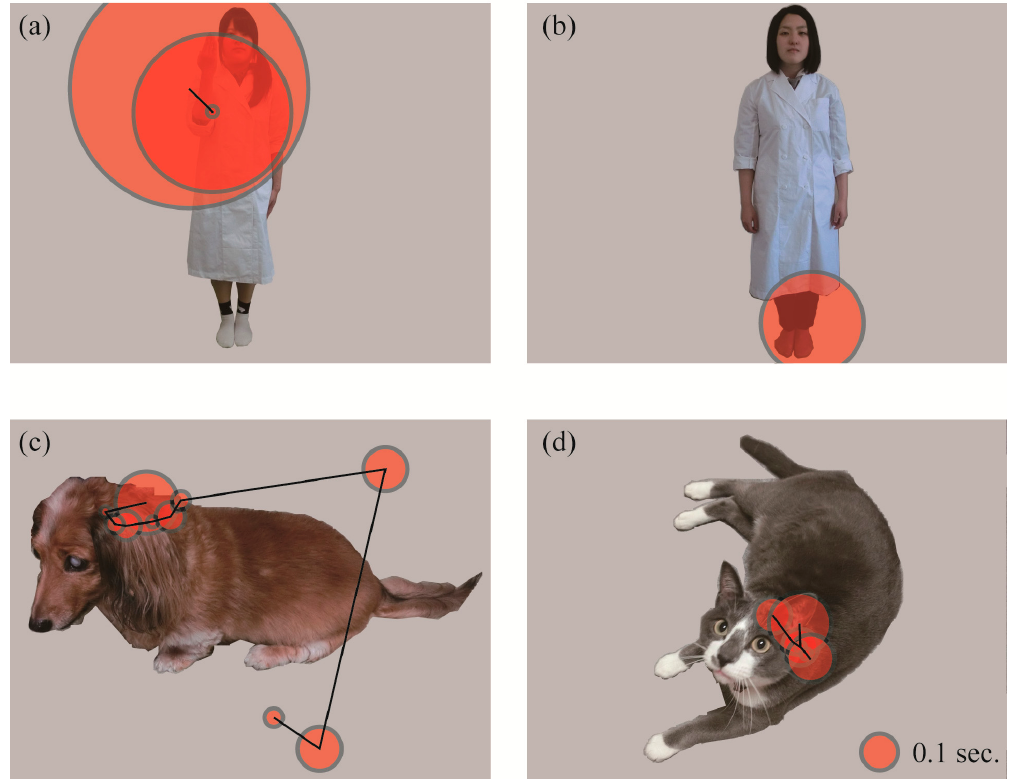
Figure 3. Examples of subjects’ gazing patterns: (a) human with a hand-sign, (b) human without a hand-sign, (c) dog, and (d) cat. Typical fixations and saccades are drawn on the pictures. The circles indicate fixations. The larger the circle, the longer the subject gazed in that area. The lines represent a saccadic path.